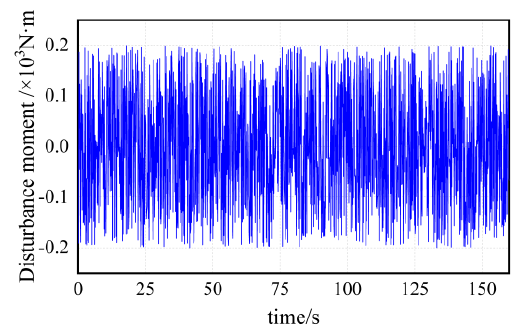
Figure 10. Turning disturbing moment.